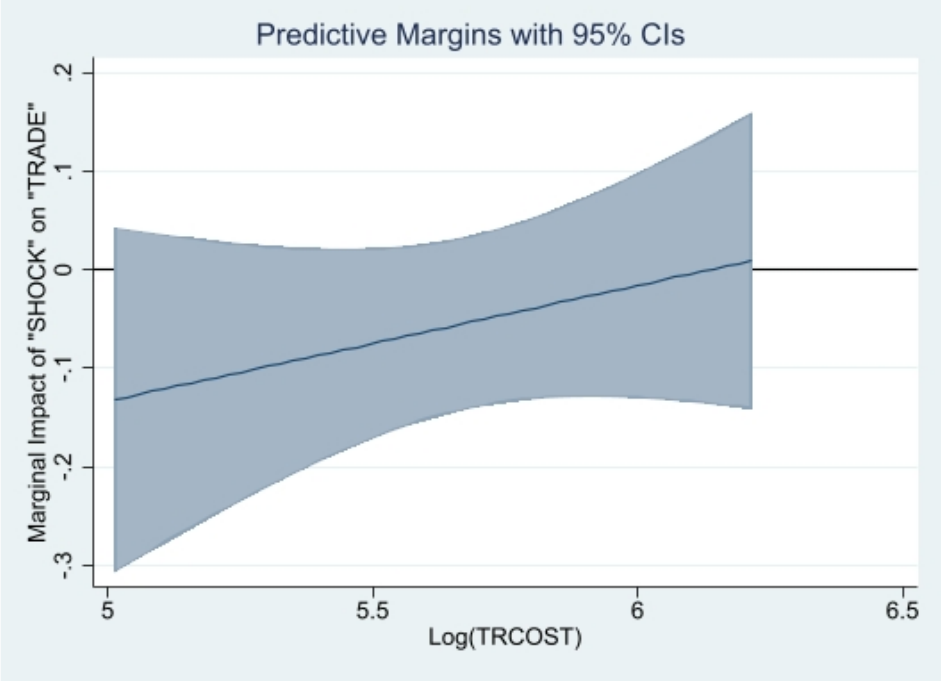
Figure 11. Marginal impact of “SHOCK” on “TRADE” for varying levels of trade costs. Source: Au- thor.